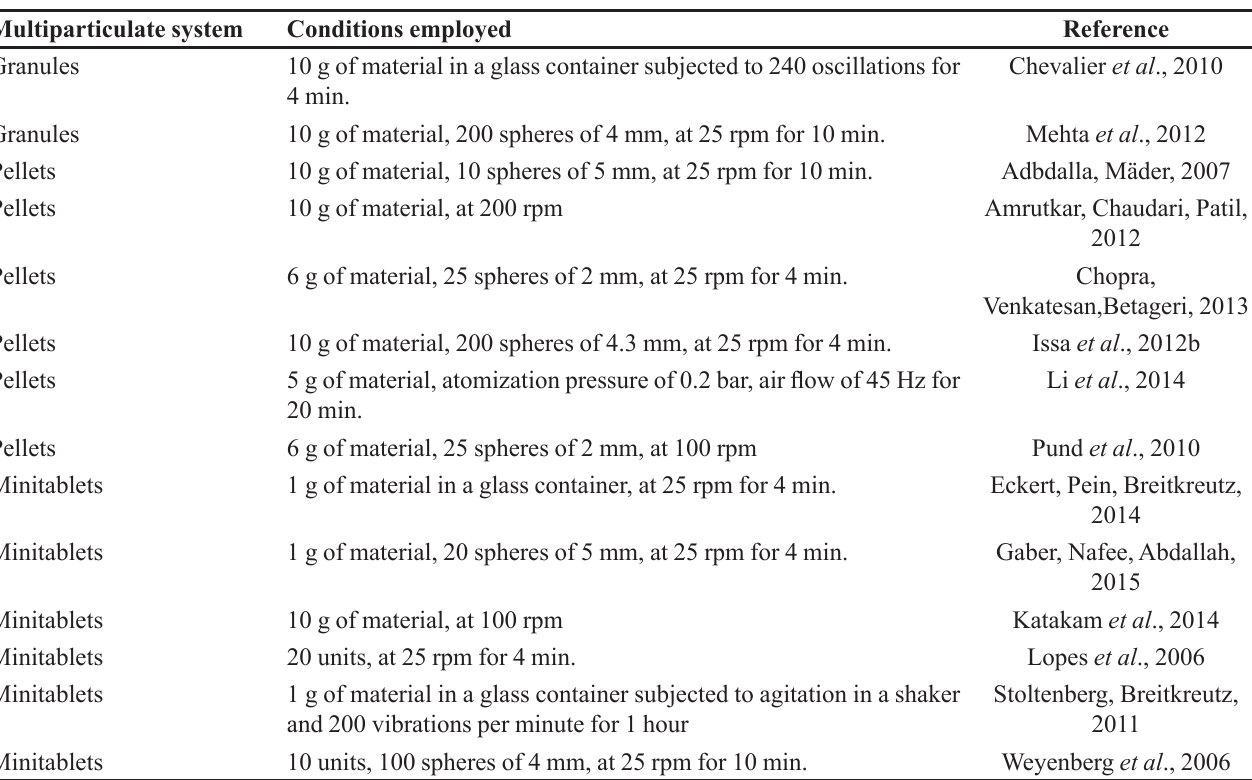
TABLE IX - Conditions employed for determination of the friability of multiparticulate systems Multiparticulate system Conditions